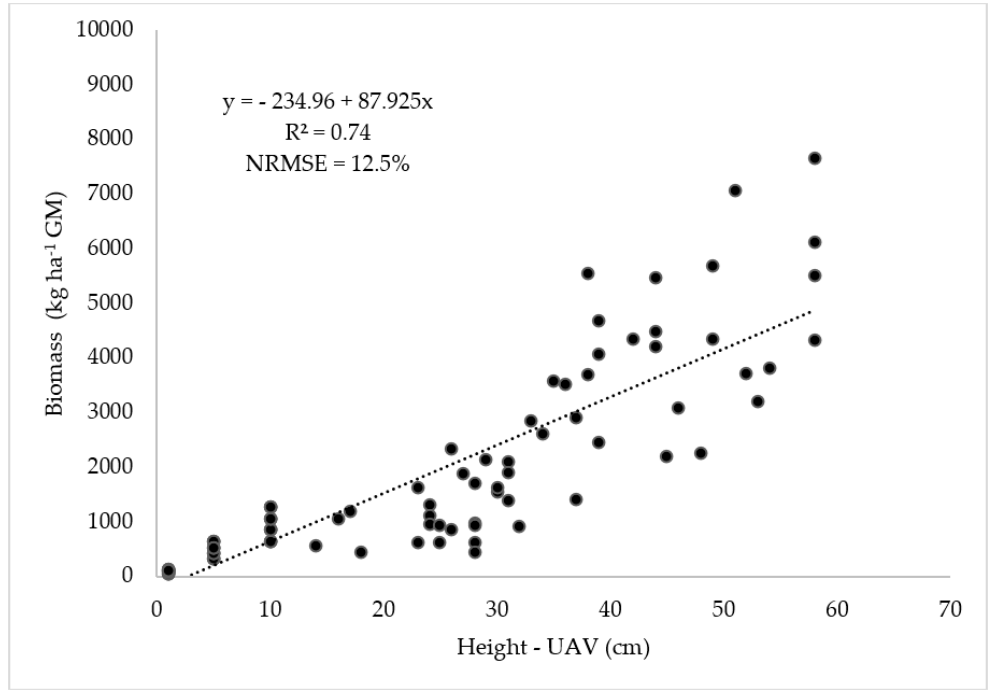
Figure 6. Relationship between the height estimated by the UAV and herbage mass. According to the regression models, the determination coefficients for the biomass estimated by the UAV and the ruler were 0.74 and 0.81, respectively. These values are higher than the 0.72 and 0.71 found by Bendig [11], who estimated the biomass of barley using a DTM and a DSM from RGB images obtained with a UAV. This corroborates the findings of Ehlert [35] and Zhang and Grift [36], who stated that there is a very close relationship between biomass and height. Each regrowth day corresponded to a 0.2422 m increase in height when measured by the ruler and 0.2098 m when calculated by the UAV (Figure 7). A similar regrowth trend was observed by Maranhão [37] and Ansah [38] that assessed the productive and structural characteristics of different cultivars submitted to different cutting intervals.